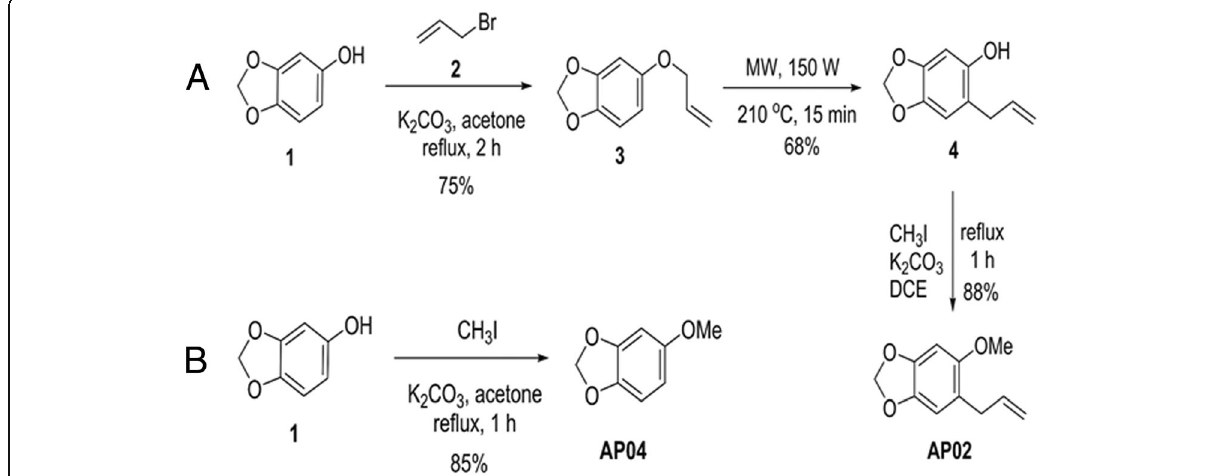
Fig. 1 Chemical synthesis of apiole and its derivatives ( a AP-02 and b